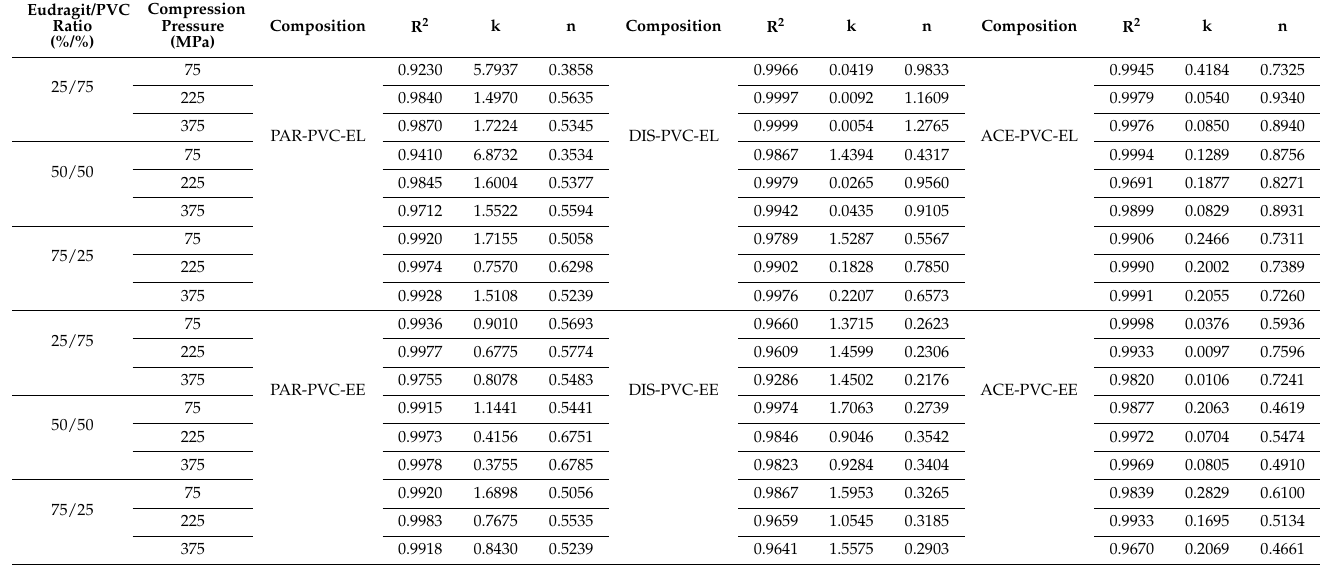
Table 5. Release rates and release exponents derived from the Korsmeyer–Peppas model (24 h long